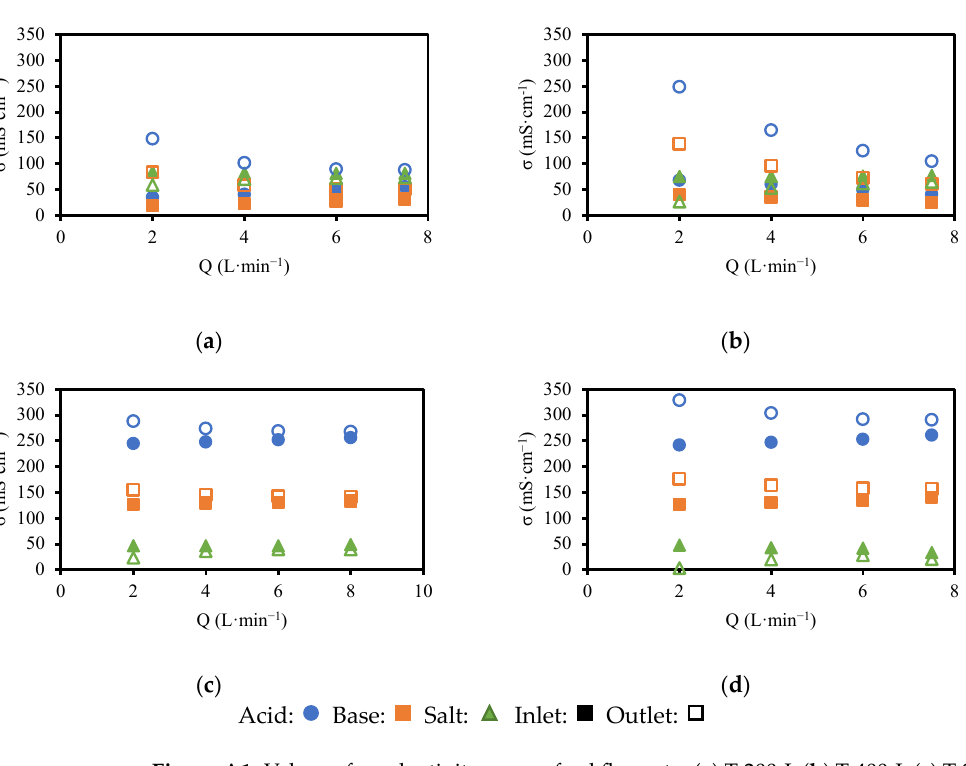
Figure A1. Values of conductivity versus feed flowrate: ( a ) T ‐ 200 ‐ I; ( b ) T ‐ 400 ‐ I; ( c ) T ‐ 200 ‐ F; ( d ) T ‐ 400 ‐ F.